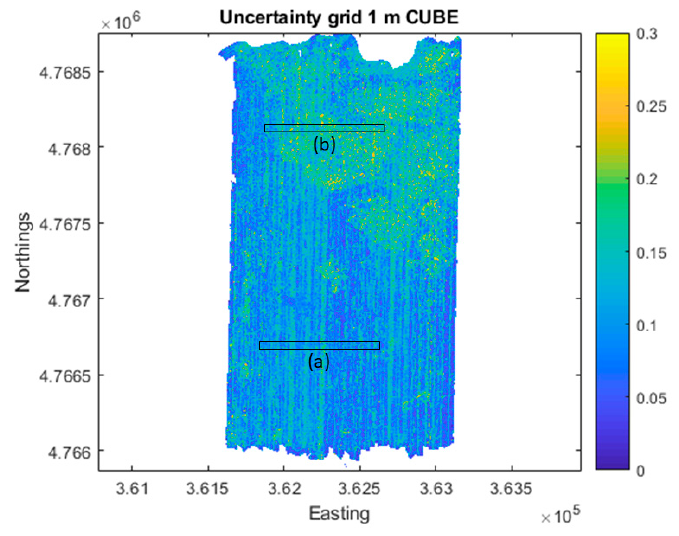
Figure 13. CUBE-generated uncertainty for the survey area. The color scale for uncertainty is given in meters. Locations of flat and rough areas displayed in Figure 14 are shown as ( a ) and ( b ),